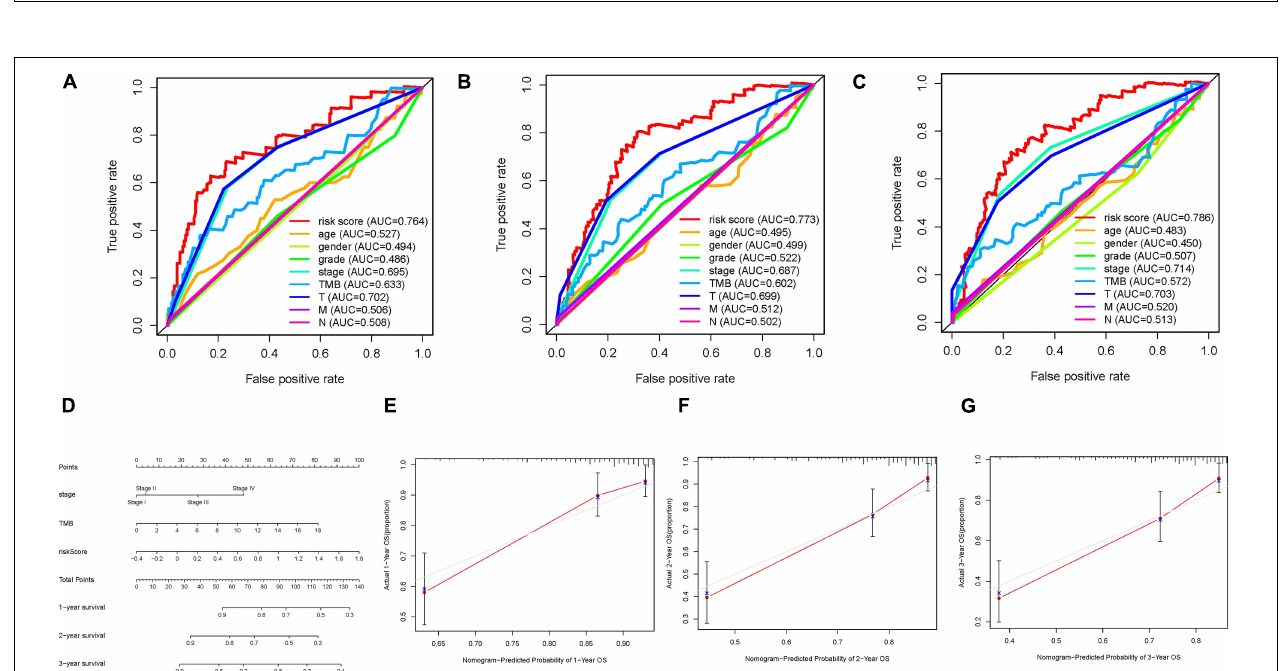
FIGURE 9 | Validation of prognostic efficiency of risk score in HCC. (A–C) Areas under curves (AUCs) of the risk scores for predicting 1-, 2-, and 3-year overall survival time with other clinical characteristics. (D) Nomogram was assembled by age and risk signature for predicting survival of HCC patients. (E) One-year nomogram calibration curves. (F) Two-year nomogram calibration curves. (G) Three-year nomogram calibration curves.